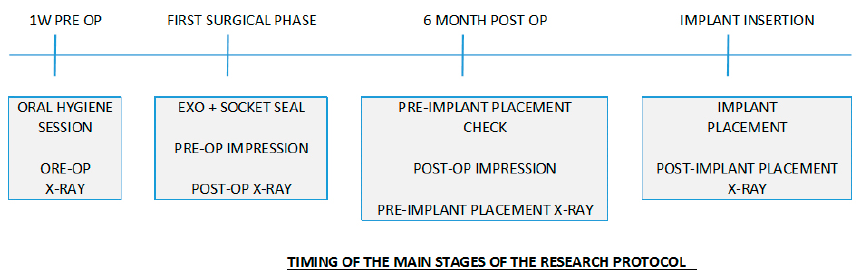
Figure 1. Timing of the main stages of the protocol during soft tissue analysis.